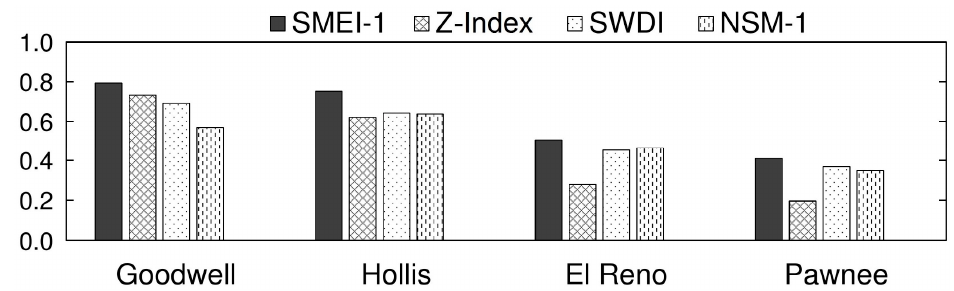
Figure 8. Correlation coefficients of existing indices and Soil Moisture Evapotranspiration Index (SMEI) with winter wheat production during the growing season at Goodwell ( a ), Hollis ( b ), El Reno Pawnee ( d ). ( c ), and Pawnee ( d ).